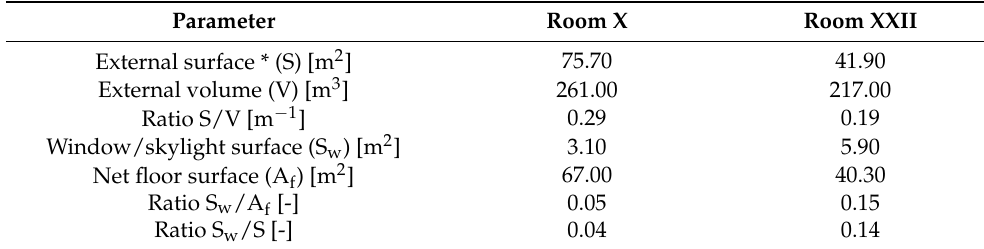
Table 3. Geometric data of La Specola museum rooms X and XXII.